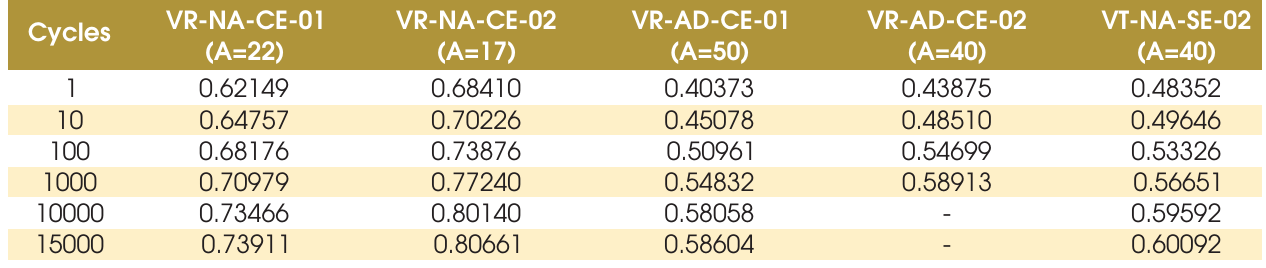
Table 4 – Damage values at maximum bending moment sections obtained by the theoretical